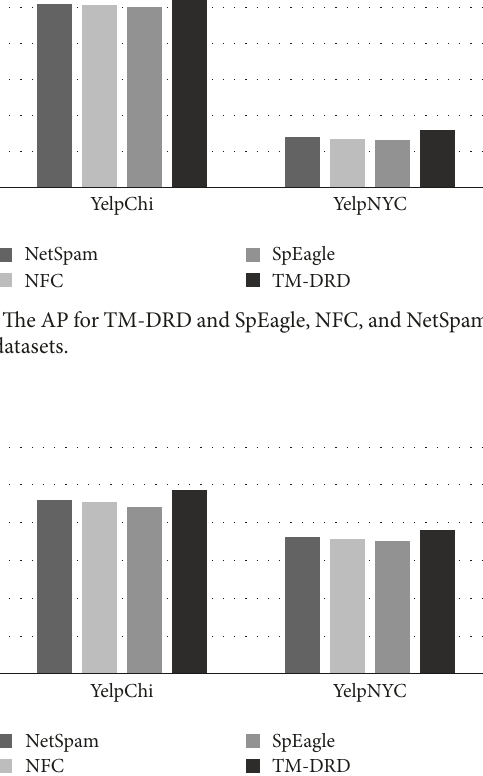
Figure 6: The AUC for TM-DRD and SpEagle, NFC, and NetSpam in different datasets.